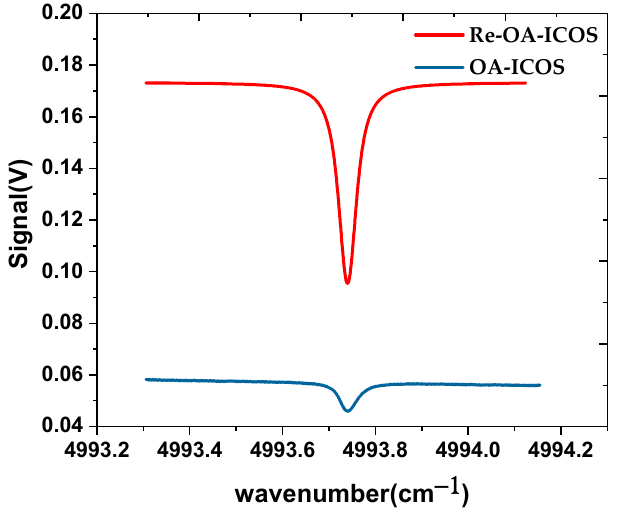
Figure 4. Absorption spectra were compared with or without reinjection systems. The red line is the RE-OA-ICOS absorption signal, the blue line is the OA-ICOS absorption signal; the RE-OA-ICOS signal strength is 6.3 times that of OA-ICOS.